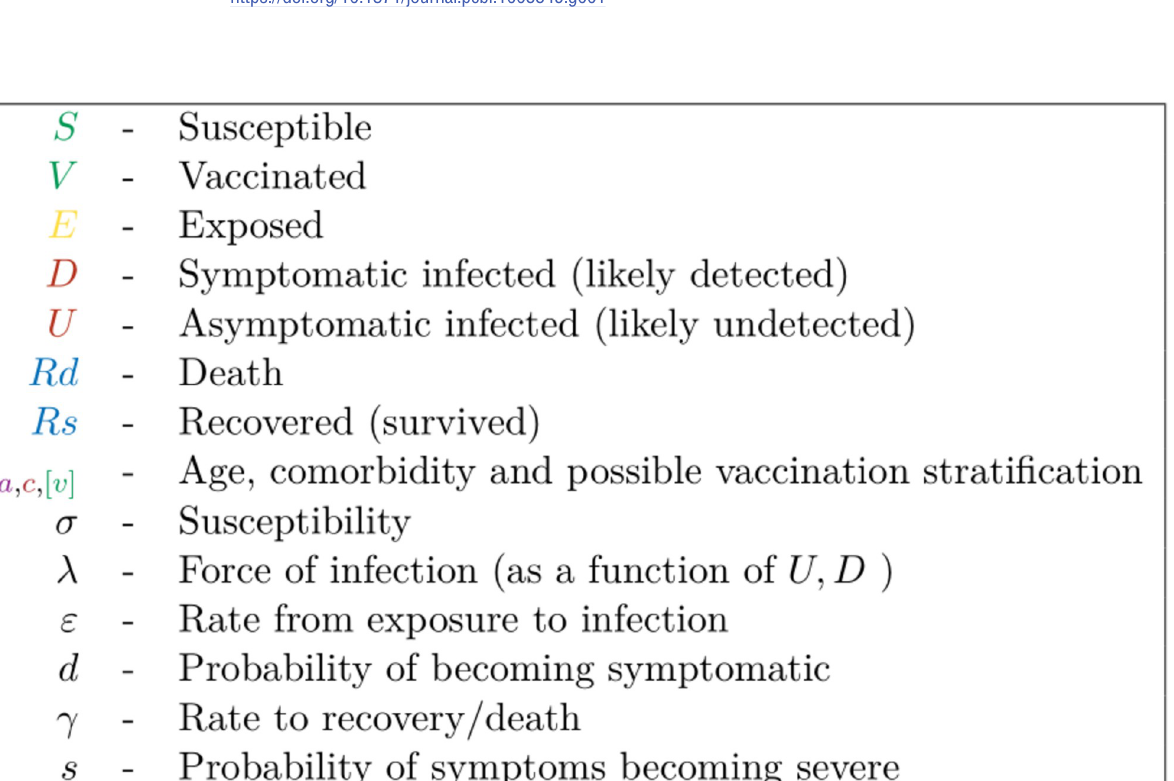
Fig 2. Description of model